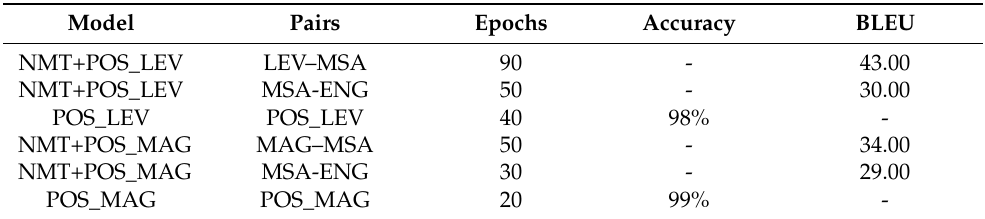
Table 8. Results of Multi-Task NMT Model with POS tagging using FAST Text Embedding that was proposed by Baniata